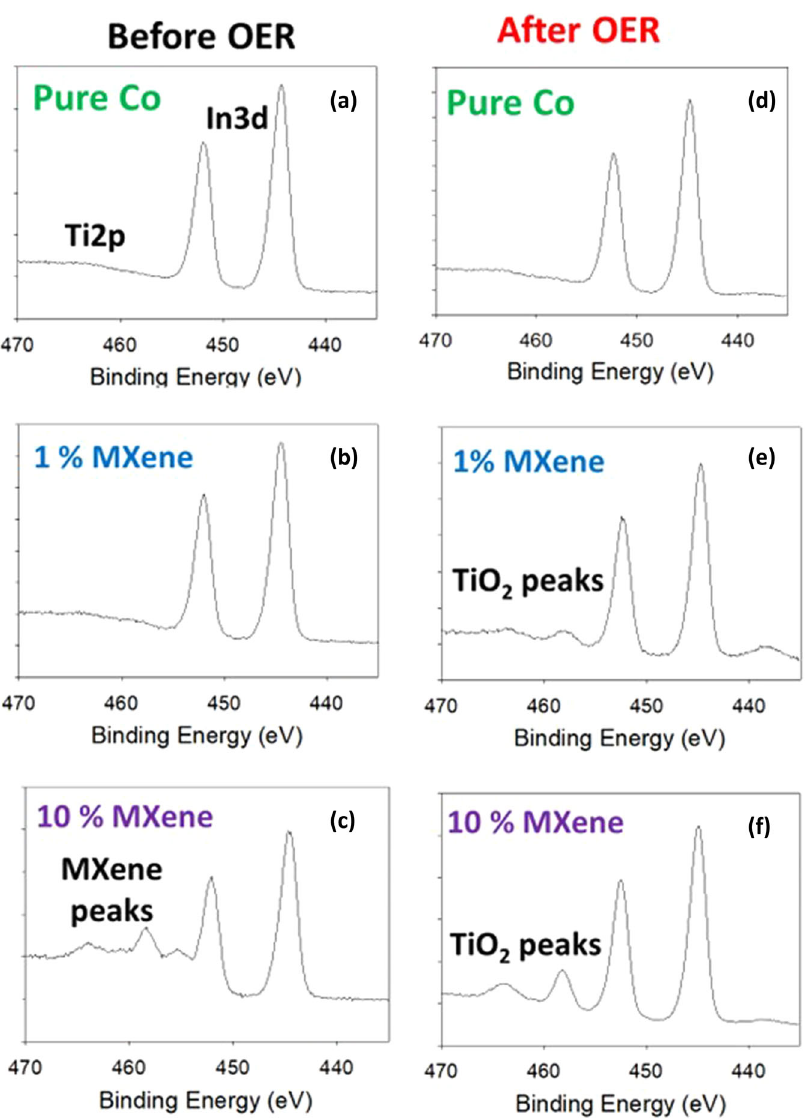
Fig. 10 Investigation into structural changes before and after OER. X-ray photoelectron spectroscopy high resolution Ti2 p /In3 d core levels before OER for ( a ) pure Co, ( b ) 1% MXene, ( C ) 10% MXene. X-ray photoelectron spectroscopy high resolution Ti2 p /In3 d core levels after OER for ( d ) pure Co, ( e ) 1% MXene, ( F ) 10%